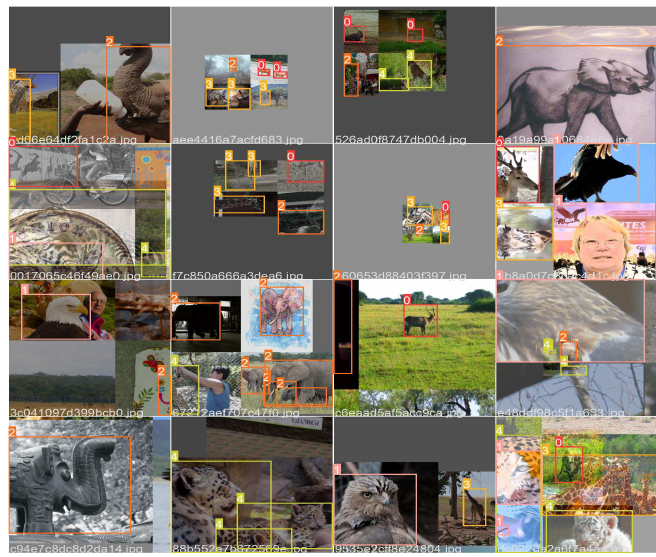
Figure 9. Example of wildlife dataset.